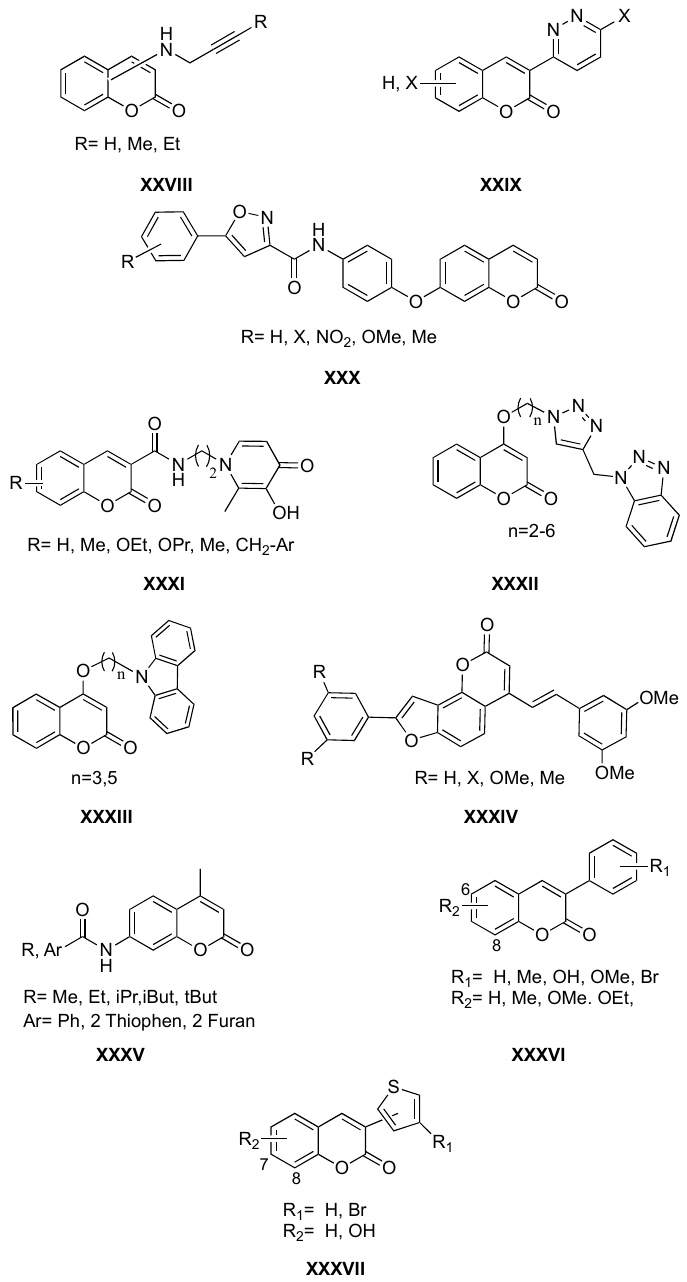
Figure 7. Structures of coumarin derivatives as anti-neurodegenerative diseases agents.